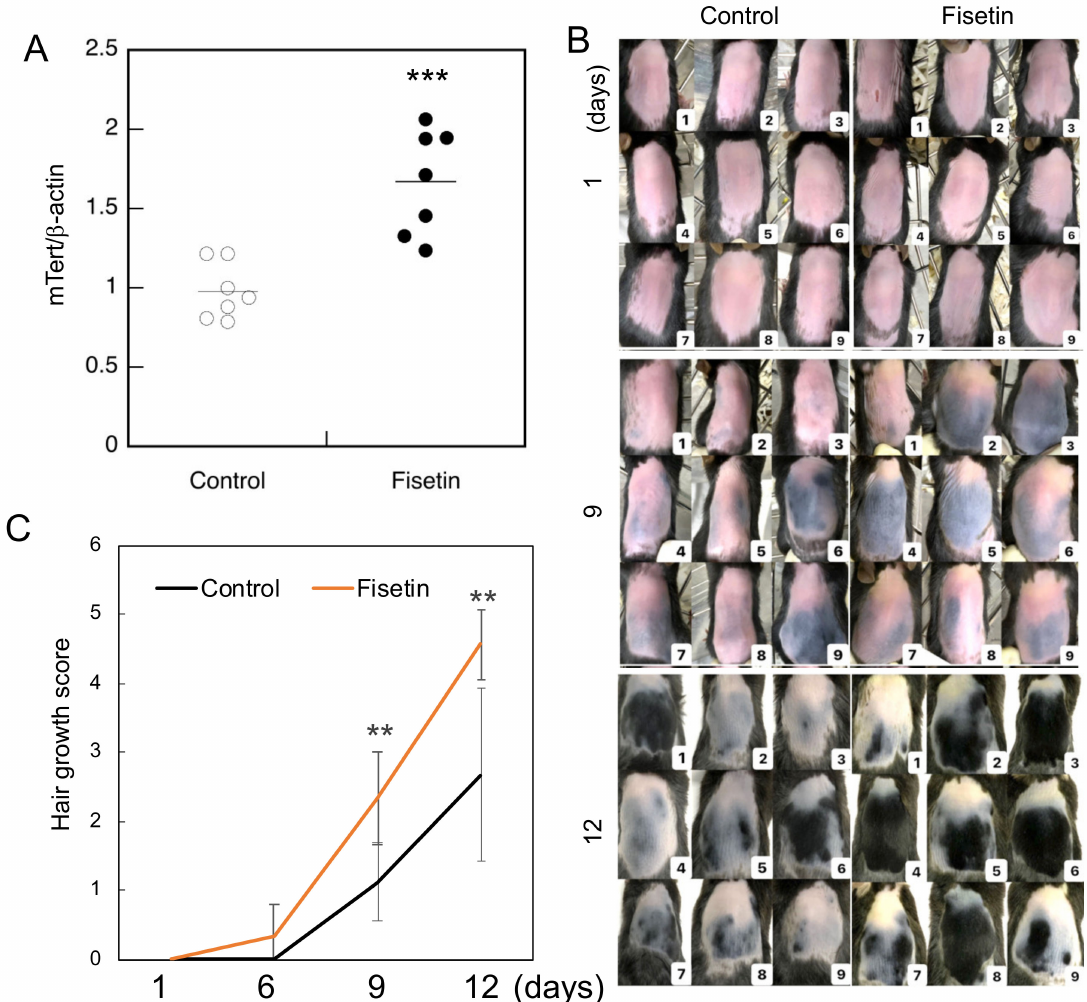
Figure 1. Hair growth-promoting effect of fisetin. ( A ) The expression of mTert in the dorsal skin cells of fisetin-treated mice and investigated using qRT-PCR. ( B ) Evaluation of the effect of fisetin treatment on the dorsal skin of C57BL/6 mice and hair growth after 12 days. ( C ) Hair growth score of fisetin-treated and control groups (the entire shaved back is pink = 0; part of the shaved back is blue = 1; part of the shaved back is gray = 2; the entire shaved back is gray = 3; part of the shaved back is black = 4; the entire shaved back is black = 5). Statistical significance was determined using a two-sided Student’s t-test. Statistical significance was defined as p < 0.05 (** p < 0.01; *** p <